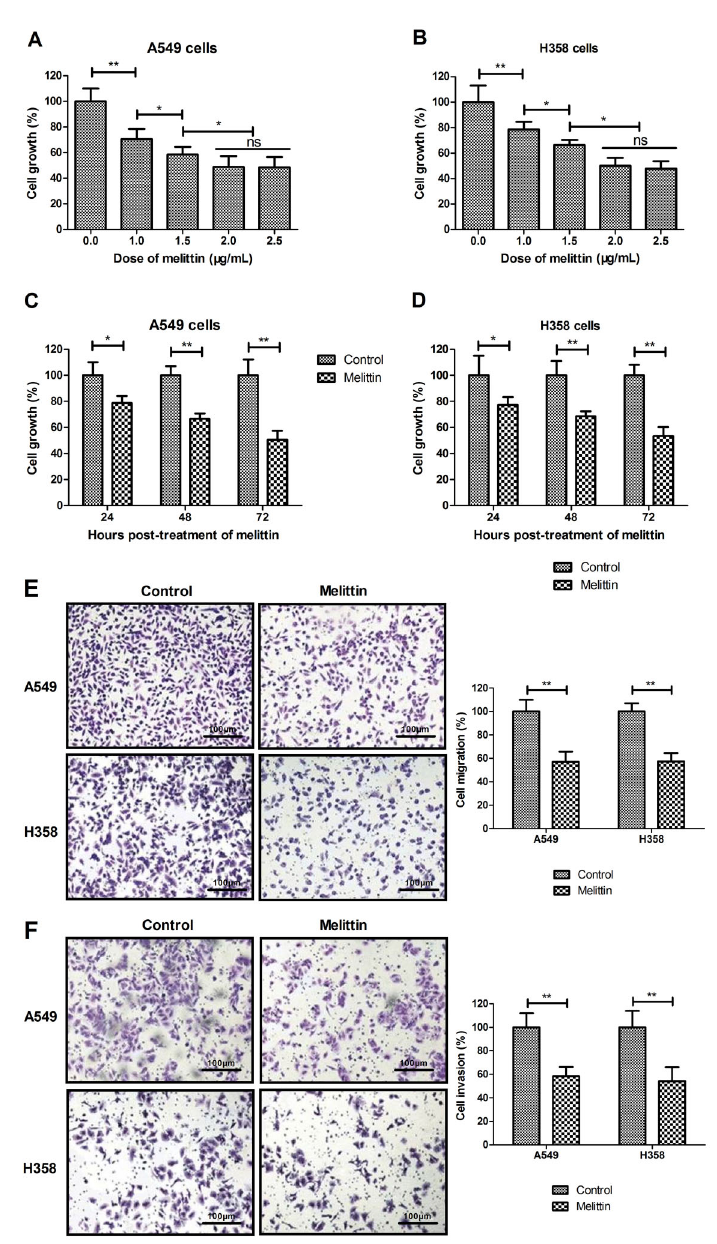
Figure 1. Melittin inhibited growth, migration, and invasion of non-small-cell lung cancer (A549 and H358) cells in vitro. A and B , Effects of different doses of melittin on cell growth after 72-h incubation. C and D , Melittin (2.0 m g/mL) treatment suppressed cell growth in a time-dependent manner (24, 48, and 72 h). Control, PBS-treated cells. E and F , Melittin (2.0 m g/mL) inhibited migration ( E ) and invasion ( F ) of cells (scale bar: 100 m m). *P o 0.05, **P o 0.01 (Student ’ s t -test and ANOVA). ns: not signi fi